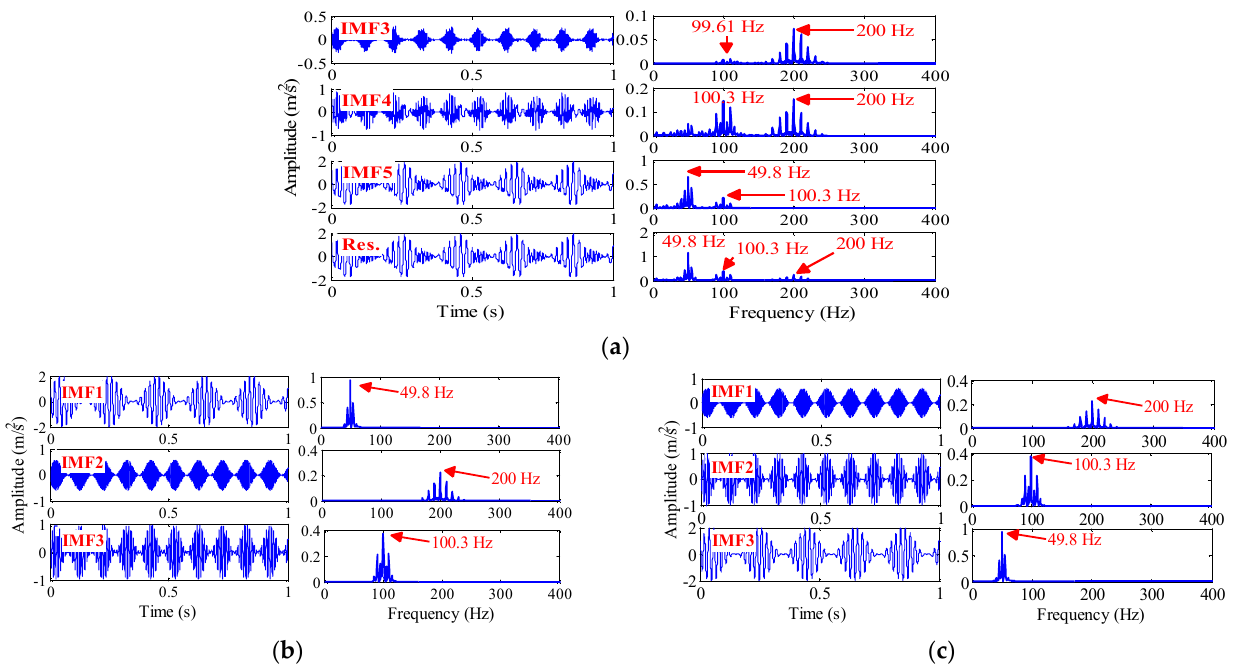
Figure 6. The decomposition results of simulated signal x(t) obtained by: ( a ) EEMD; ( b ) VMD; and ( c ) TVF-EMD.